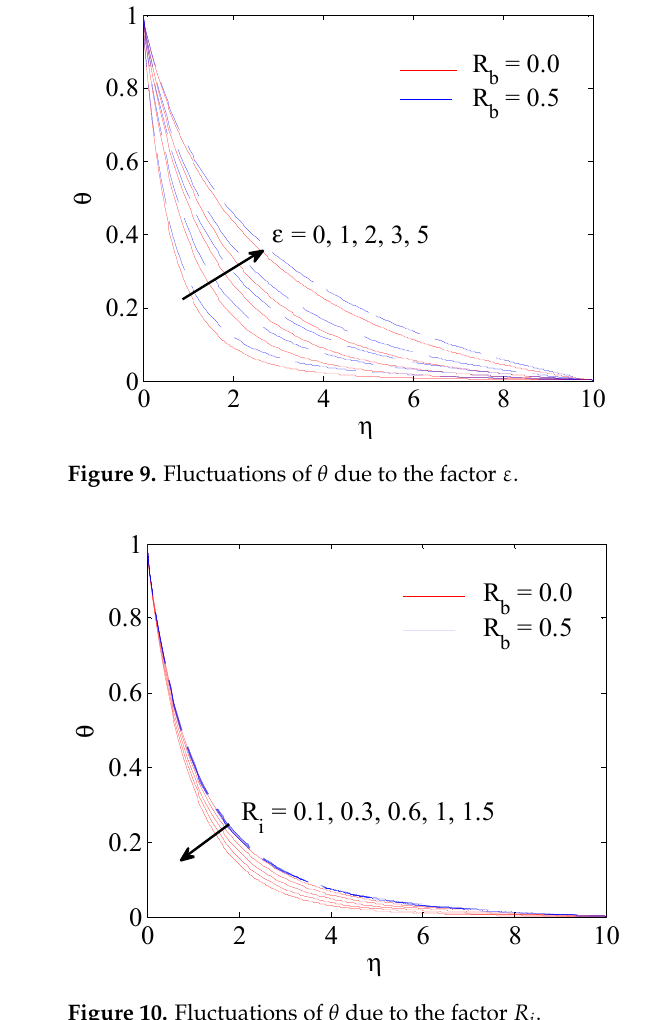
Figure 10. Fluctuations of θ due to the factor R i .